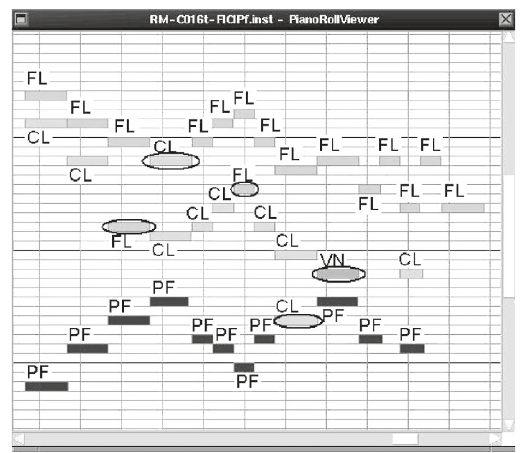
Figure 2: Example of musically unnatural errors. This example is excerpted from results of identifying each note individually in a piece of trio music. Marked notes are musically unnatural errors, which can be avoided by using musical context. PF, VN, CL, and FL represent piano, violin, clarinet, and